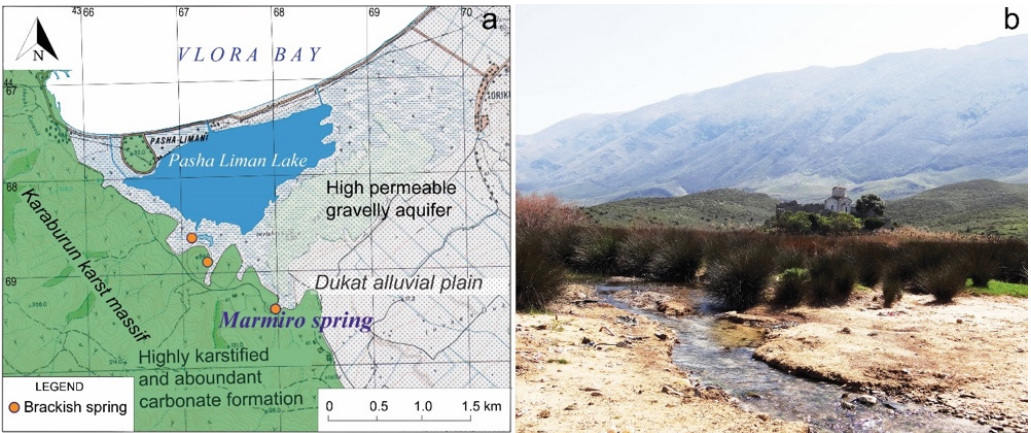
Figure 8. ( a ) Location of Marmiro Spring; ( b ) Marmiro Spring near the Marmiro church. Table 3. Main characteristics of brackish cold karst springs of the Ionian coastal areas of Albania.